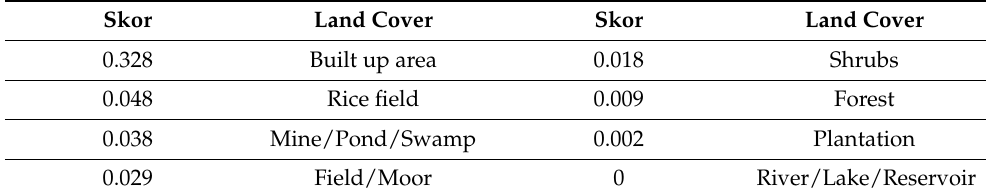
Table 2. Land cover weight for the population distribution [44]. Skor Land Cover Skor Land Cover 0.328 Built up area 0.018 Shrubs 0.048 0.009 Forest 0.038 Mine/Pond/Swamp 0.002 Plantation 0.029